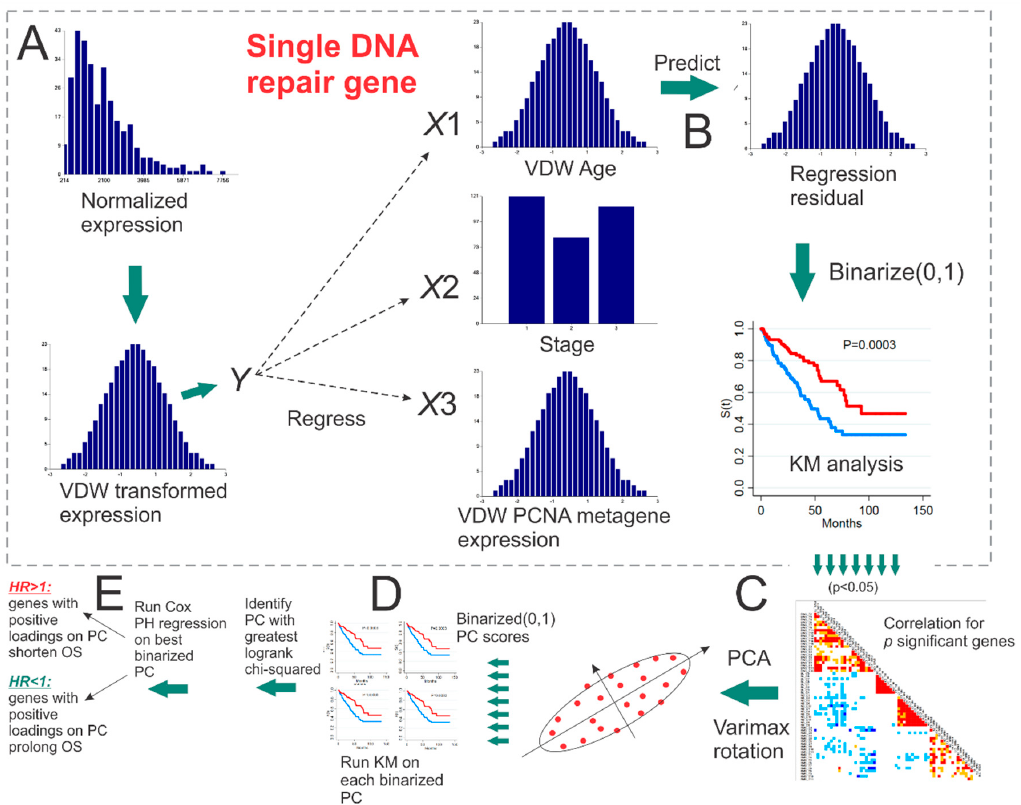
Figure 4. Workflow for identifying the “best binarized PC” for a set of significant genes from univariate Kaplan-Meier analyses. ( A ) van der Waerden (VDW) scores of log-transformed expression values for each DNA repair gene are regressed on the VDW scores for age at diagnosis, stage, and the PCNA metagene. ( B ) The residual values from each linear fit (i.e., expression with the effect of age at diagnosis, stage, and PCNA metagene removed) are then binarized (0,1) and input as the univariate grouping value during Kaplan-Meier (KM) analysis of overall survival (OS). ( C ) PCA with Varimax orthogonal rotation is performed on the correlation matrix of p significant binarized residual vectors. ( D ) Each of the p principal component (PC) score vectors is binarized (0,1) and input into univariate KM analysis. ( E ) The PC resulting in the greatest KM chi-squared value is selected as the “best binarized PC,” and univariate Cox PH regression is then run on the best binarized PC to determine if positive (negative) PC score values are associated with prolonged (shortened)